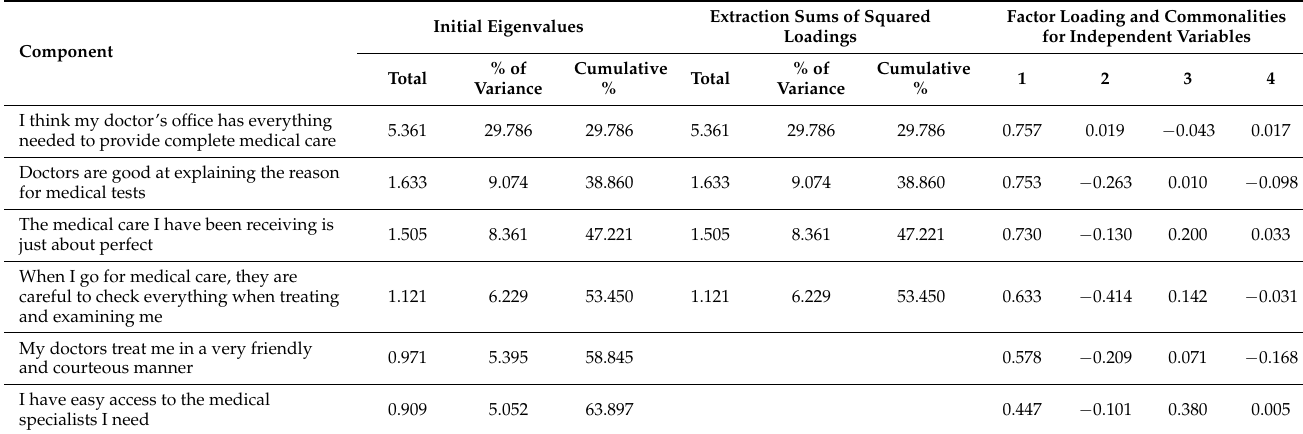
Table 4. Principal component analysis (PCA) summarizing patient